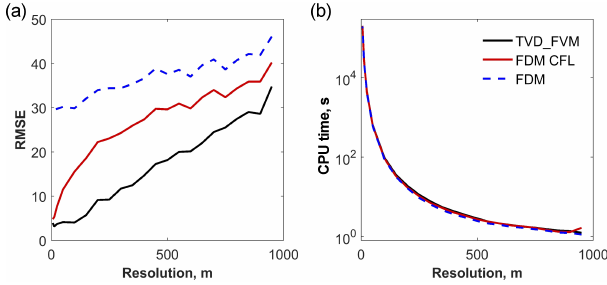
Figure 5. (a) Performance of the different numerical schemes where the RMSE is calculated between the analytical and numer- ical methods. (b) CPU time required to perform the model runs at the indicated